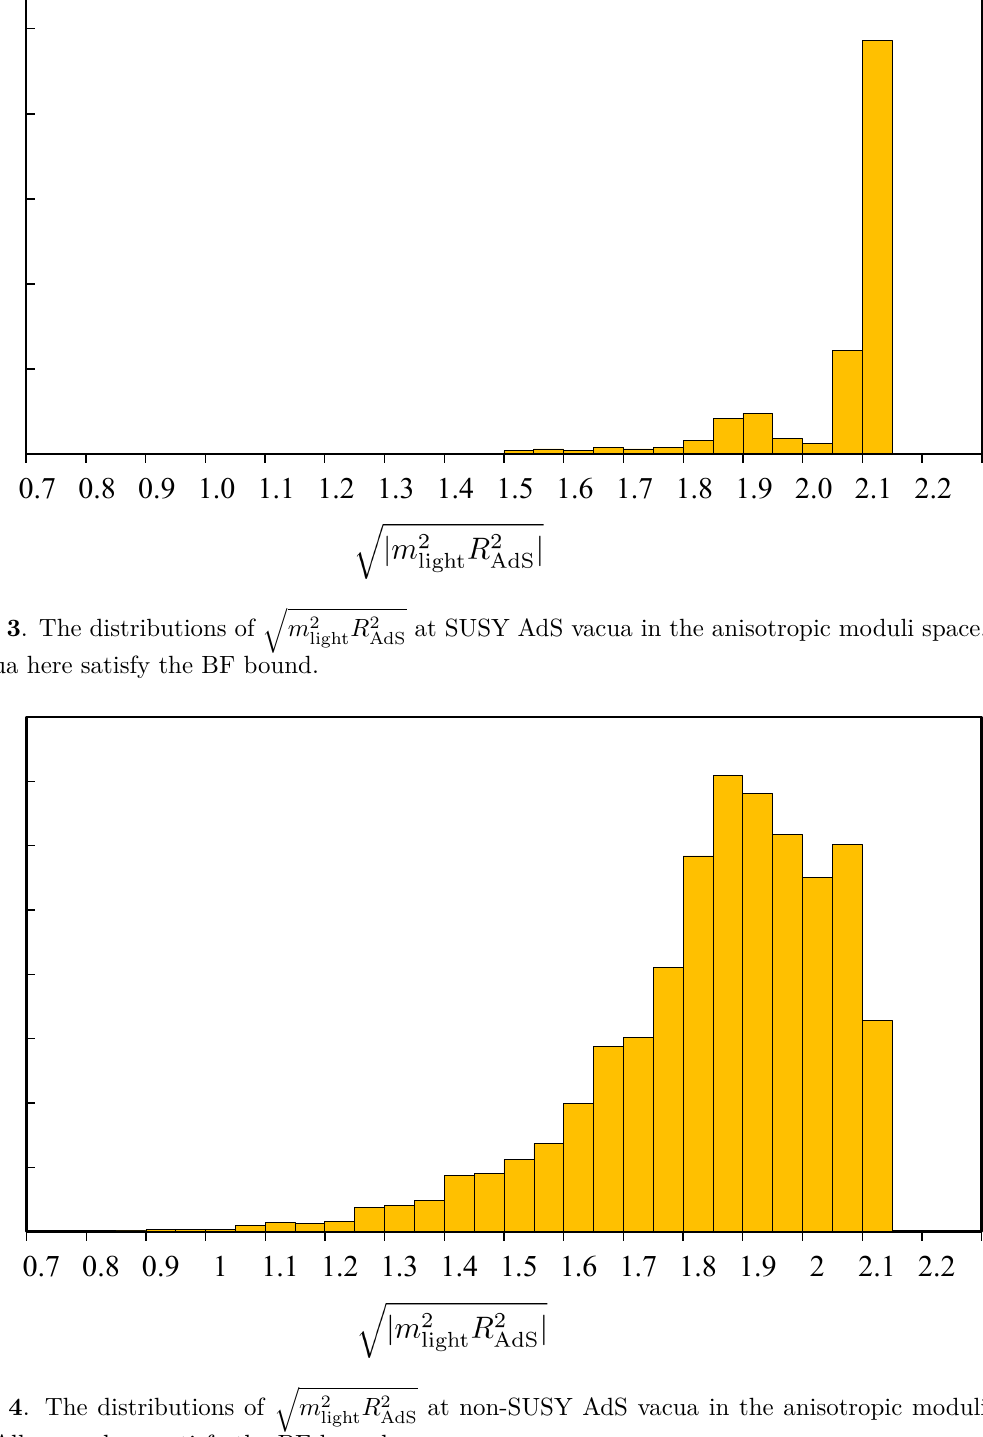
q at non-SUSY AdS vacua in the anisotropic moduli m 2 R 2 light AdS